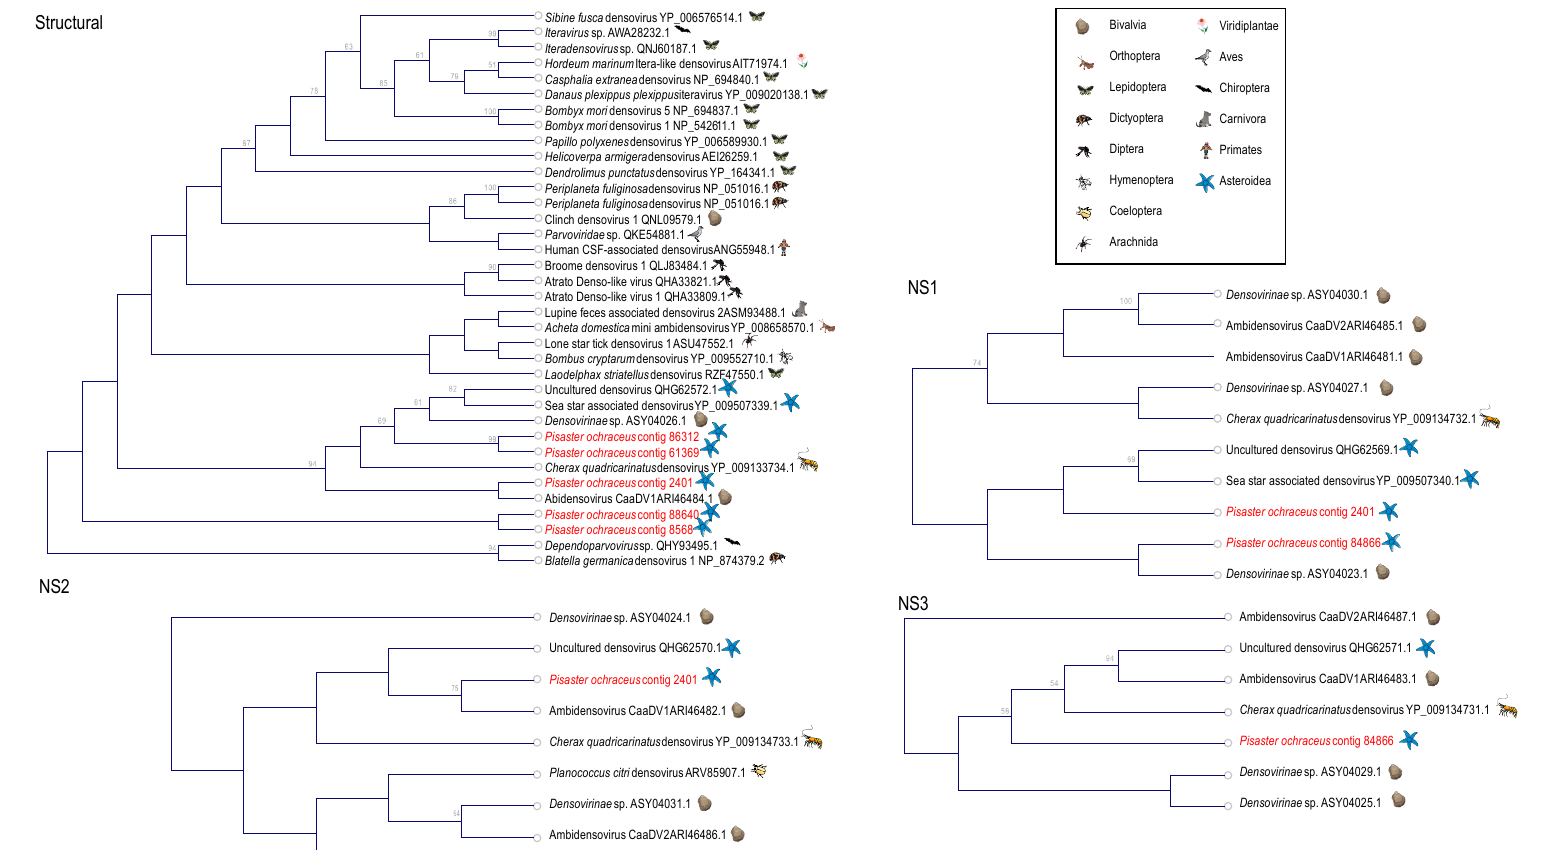
Figure 7. Phylogenetic representations of Densovirinae -like genome fragments recovered from Pisaster ochraceus . The cladorgrams were constructed based on: a 103 amino acid alignment of the structural (coat protein) gene; a 83 amino acid of the non-structural 1 (NS1) gene; a 112 amino acid of the NS2 gene; and a 111 amino acid of the NS3 gene. Phylogenetic representations include best matches by BLASTx against the non-redundant database at NCBI. Trees were constructed by Neighbor Joining and based on Jukes-Cantor distance using the CLC Genomics Workbench 4.0 (Qiagen). Bootstrap values > 50% (based on 1000 iterations) are indicated above nodes. The host identity is indicated by symbols next to branch labels. An additional phylogenetic representation of each tree based on maximum likelihood is presented in Figure S6.